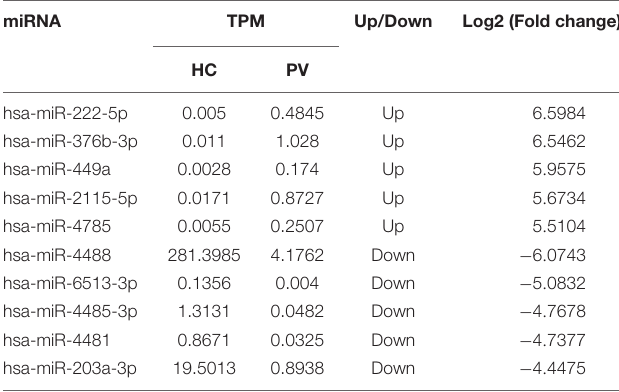
TABLE 2 | Top differential miRNAs between psoriasis vulgaris (PV) patients and healthy control.